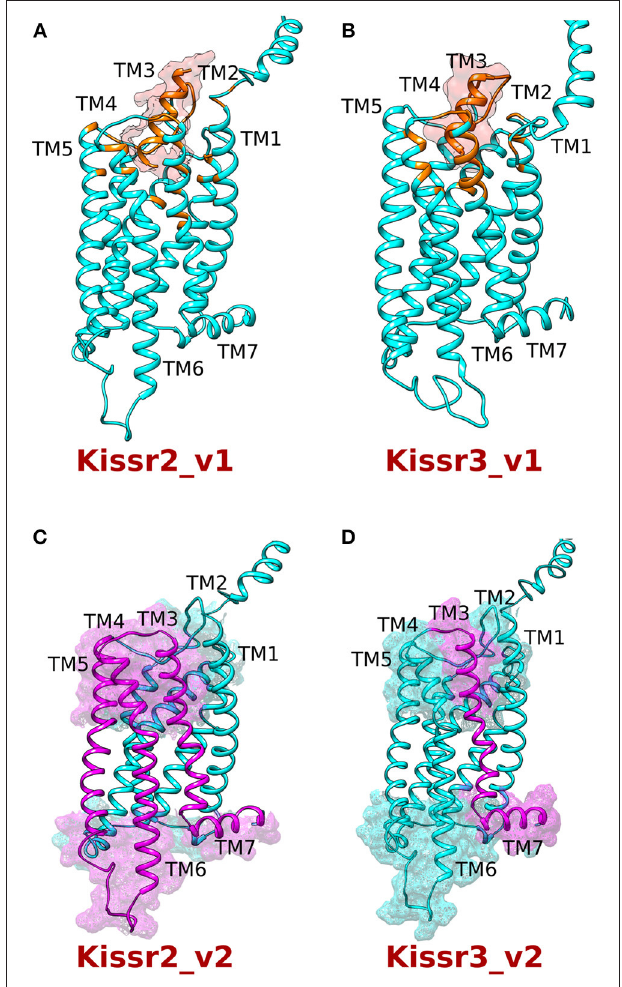
FIGURE 4 | Homology modeling of the kisspeptin receptors (Kissr2 and Kissr3) with their respective peptides kiss1 and kiss2. (A) Kissr2_v1 receptor (cyan) and (B) Kissr3_v1 receptor (cyan) with their respective peptides (orange). The residues located within 5 Å from the peptides are shown in orange. (C,D) The truncated region of both the receptors is shown in violet. While receptor Kissr2_v2, lacks TM5-TM7 helixes; Kissr3_v2 loses TM7 and portion of the extracellular loop